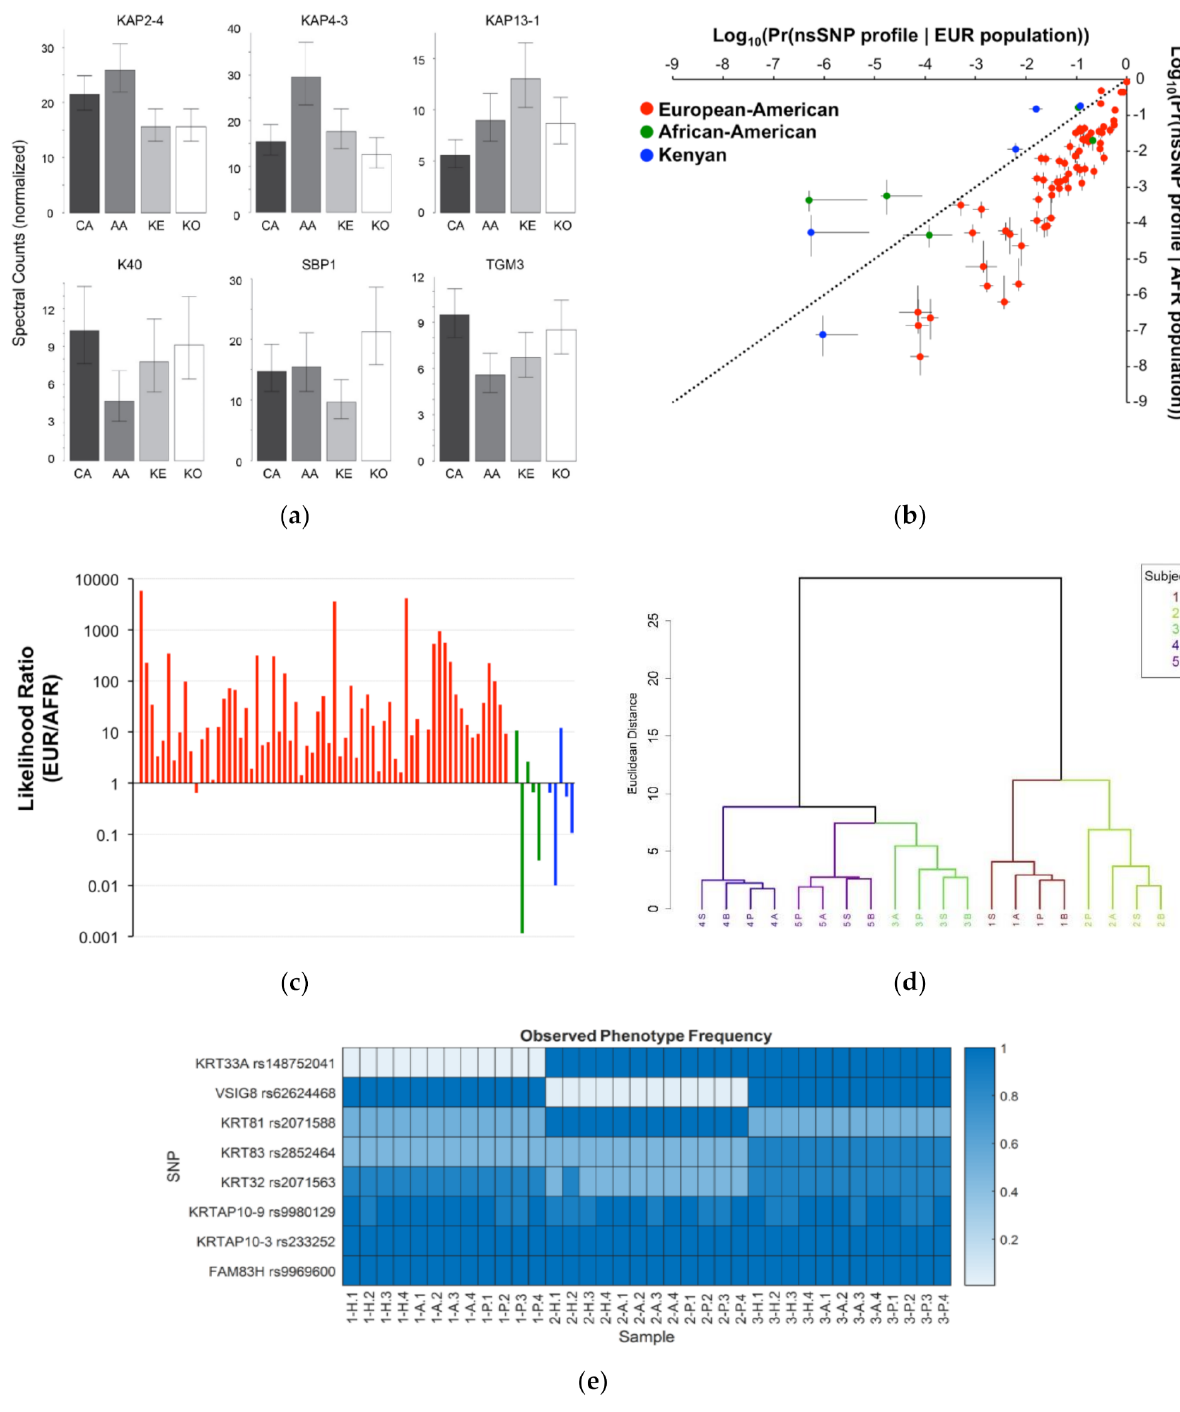
Figure 2. Applications of human hair proteomic analysis in forensic sciences. ( a ) Weighted spectral counts for six differentially expressed proteins that were in hair samples of subjects of different ethnic origin. The ethnicities are Caucasian (CA), African– American (AA), Kenyan (KE), and Korean (KO). Figure reprinted from [36] under the terms of the Creative Commons